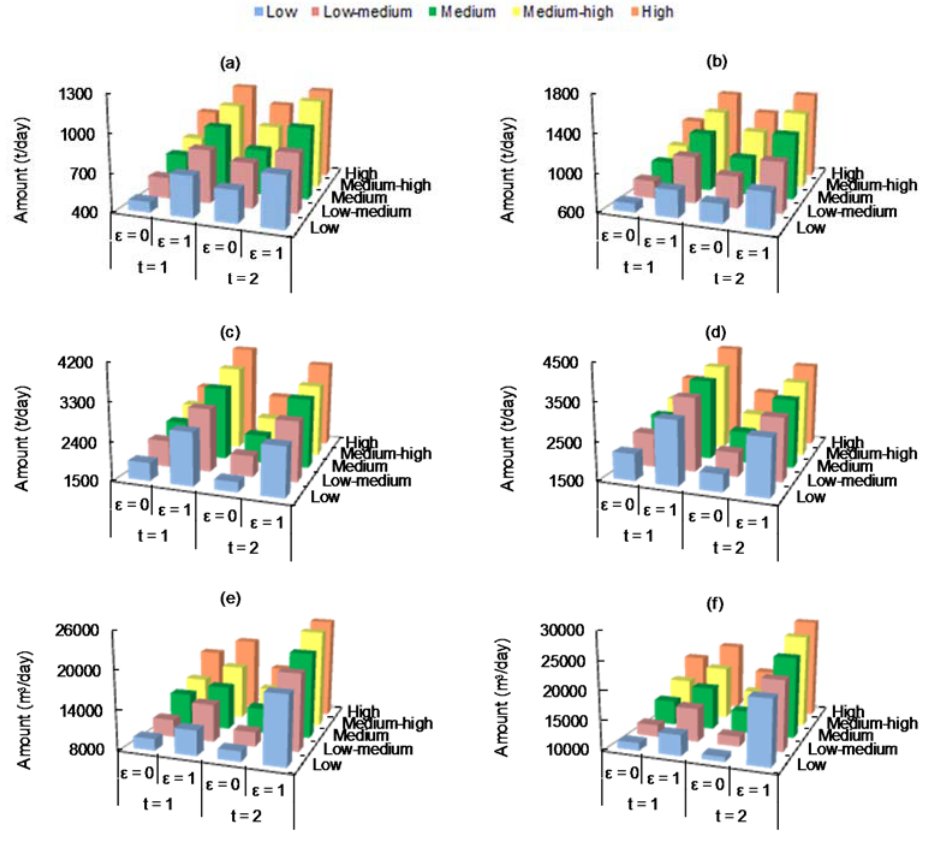
Figure 7. Actual production levels of industrial activities. Note: ( a ) lower ‐ bound production level of chemical plant; ( b ) upper ‐ bound production level of chemical plant; ( c ) lower ‐ bound production level of phosphorus mining company; ( d ) upper ‐ bound production level of phosphorus mining company; ( e ) lower ‐ bound water supply and ( f ) upper ‐ bound water supply.